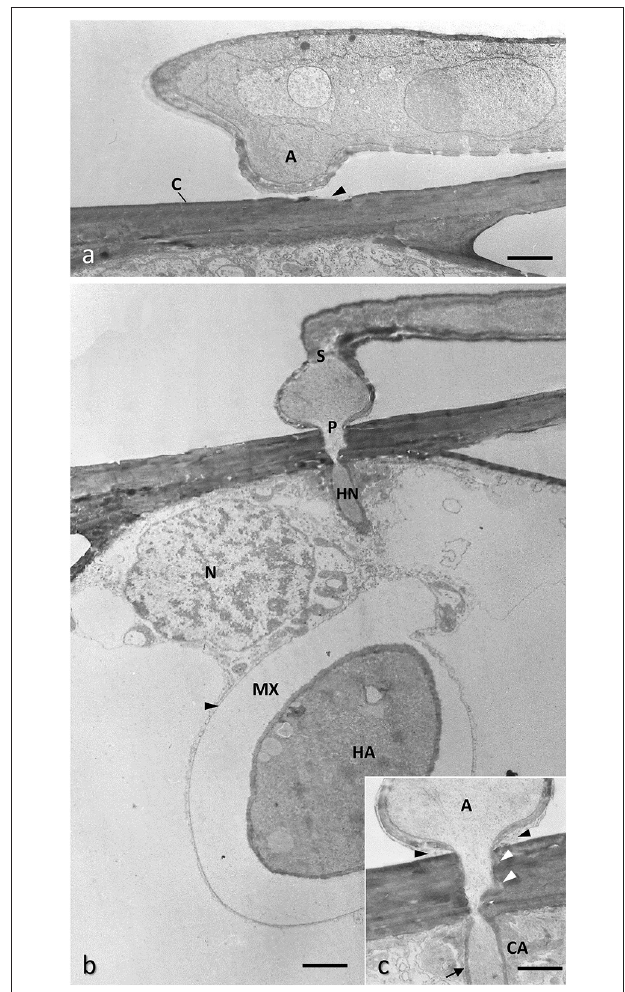
FIGURE 6 | Conventionally chemical fixed samples of barley epidermal cell infected with Blumeria graminis f.sp. hordei showing the early phase of the infection process. (a) A hypha growing on the leaf surface is generating an appressorium (A) encountering the plant cuticle (C) which appears already eroded (arrowhead) by fungal hydrolyzing enzymes. Bar, 1.2 µ m. (b) The appressorium, once separated by the hyphae by a septum (S) generates a penetration peg perforating the host cell wall and developing an infection hyphae (haustorial neck, HN) inside the host cell; this hyphae force the plasma membrane (black arrowheads) to invaginate without breaking it, then expands to form the haustorium (H) in which the content of the appressorium is transferred through the haustorial neck, part of which is not visible here because out of the section plane; the forming haustorium is separated by the host membrane by an extra-haustorial matrix (MX) rich in polysaccharides; the nucleus (N) of the host cell move close to the haustorium to facilitate transcriptional reprogram of the infected cell; courtesy of D. Maffi. Bar, 1.6 µ m. (c) Enlargement of the penetration point showing adhesive material fixing the appressorium to the cuticle (black arrowheads); the host cell wall around the penetration peg appears loosen (white arrowheads) and a callose collar (CA) is formed around the haustorial neck, whose cell wall is thickened (harrow). Bar, 1.0 µ m.